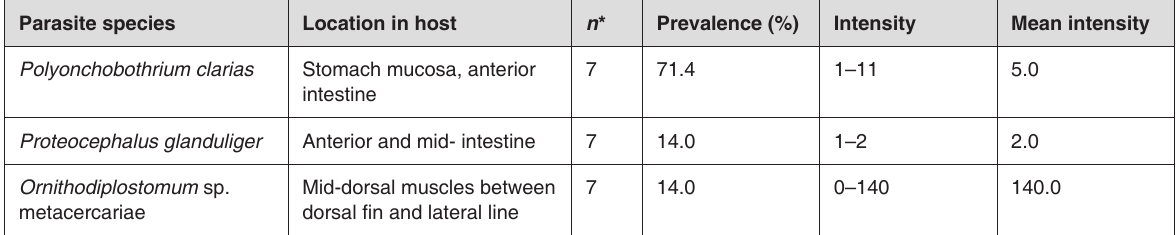
Ornithodiplostomum sp. metacercariae